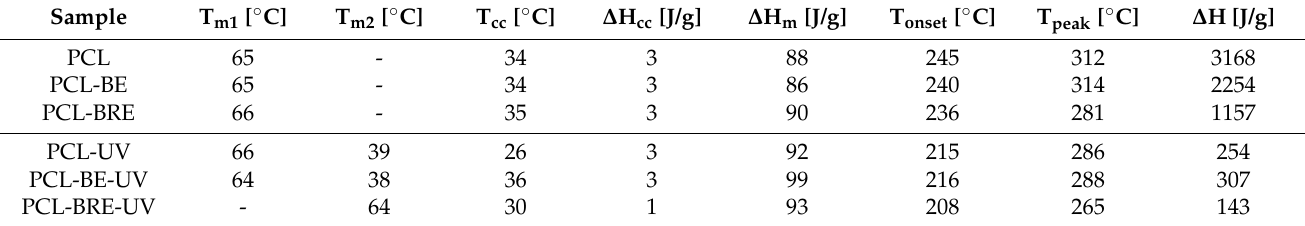
Table 2. DSC data for the neat PCL and PCL composites with bentonite and AO before and after the UV ageing test. Sample